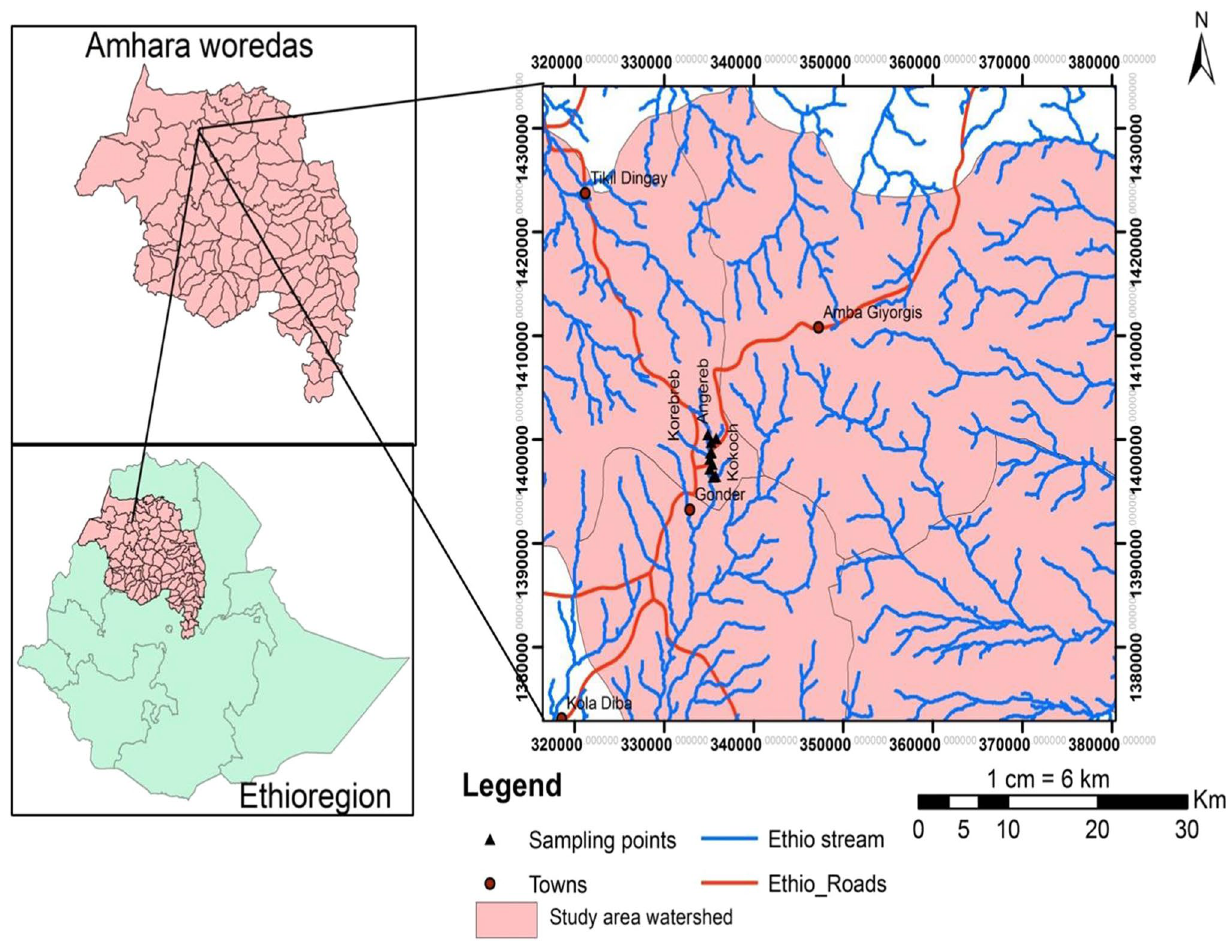
Fig. 1 Map of study area and sampling sites in Angereb